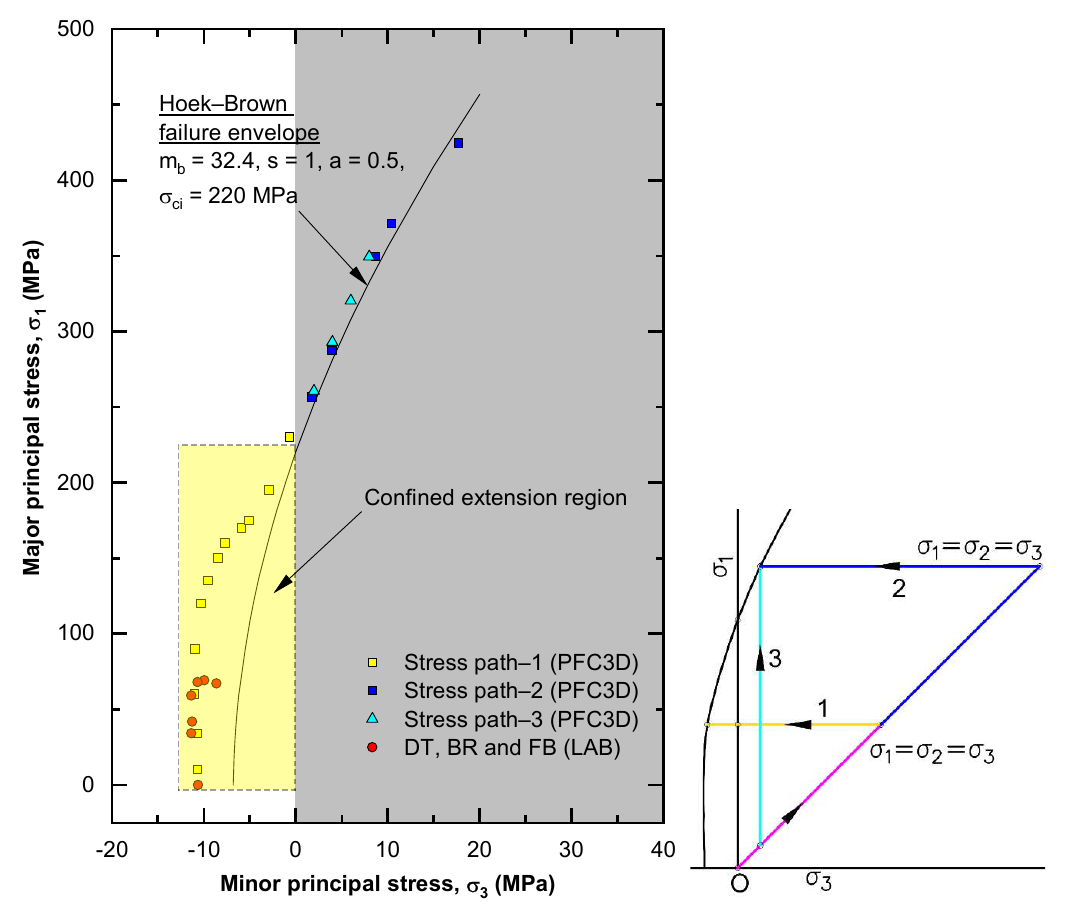
Figure 18. Results of laboratory and numerical samples on Lac du Bonnet granite. DT = direct tension, BR = Brazilian, FB = flattened Brazilian.